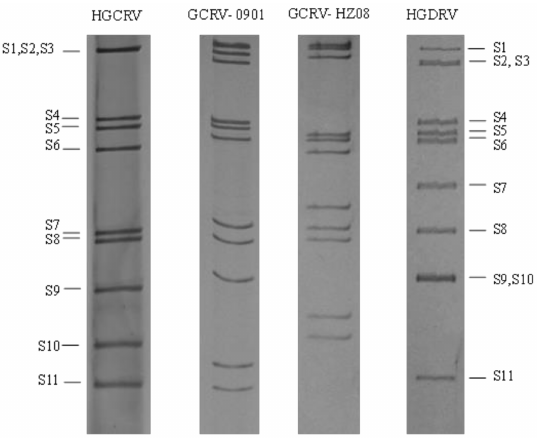
Figure 3. Electropherotype of the HGCRV genome. HGCRV, healthy grass carp